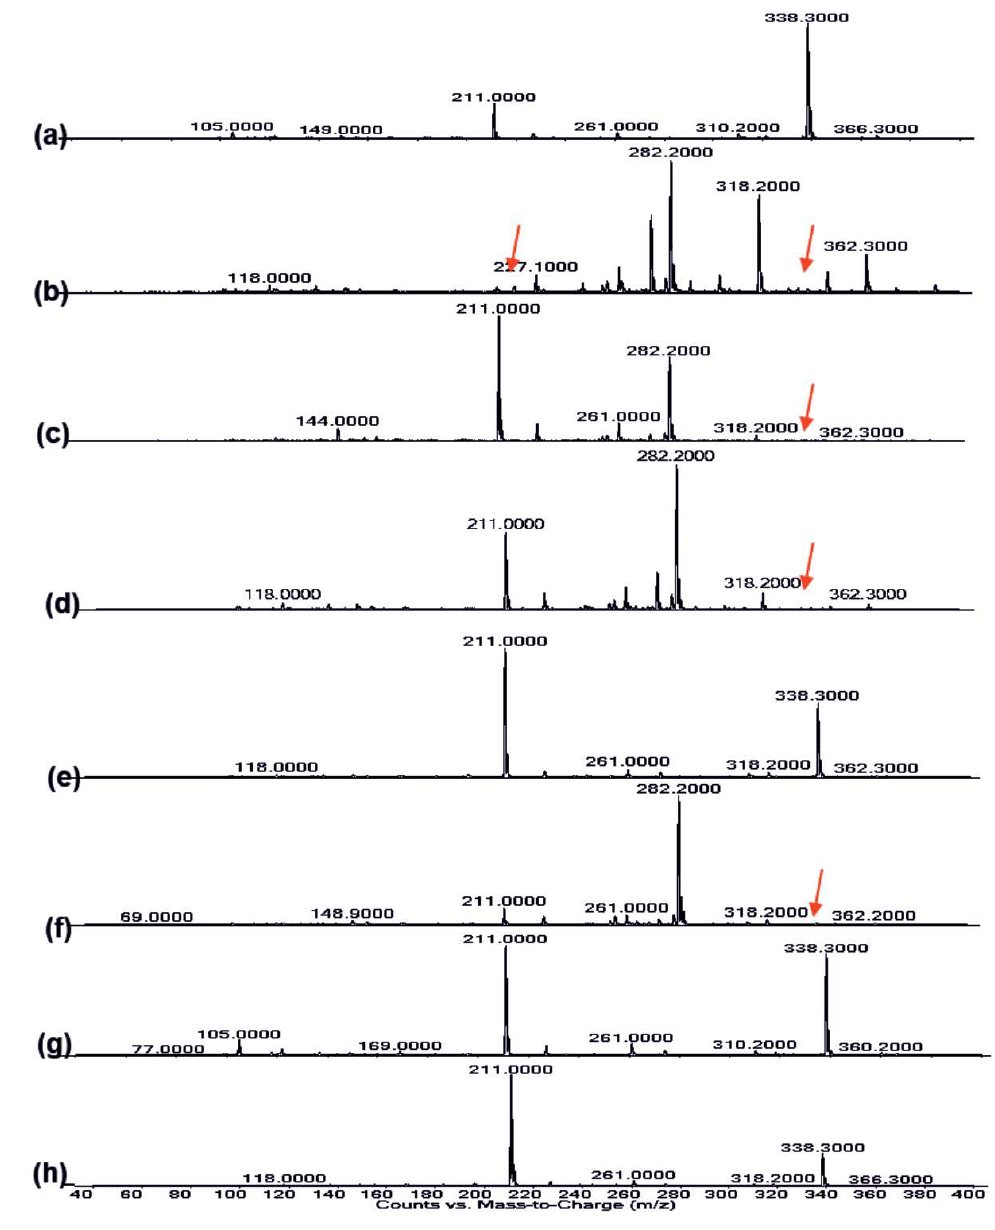
Fig. 8. LC-MS of pyocyanin extracted (a) Control, (b) Punica granatum, (c) Citrus reticulata, (d) Vitis amurensis, (e) Carica papaya, (f) Vitis vinifera, (g) Ananas comosus, (h) Ficus